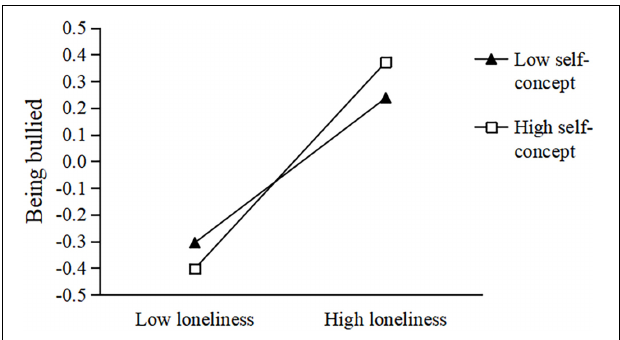
FIGURE 3 | The influence of loneliness on the relationship between being bullied and extroversion: the moderated effect of self-concept. The black triangle represents low self-concept and the white square represents high self-concept.